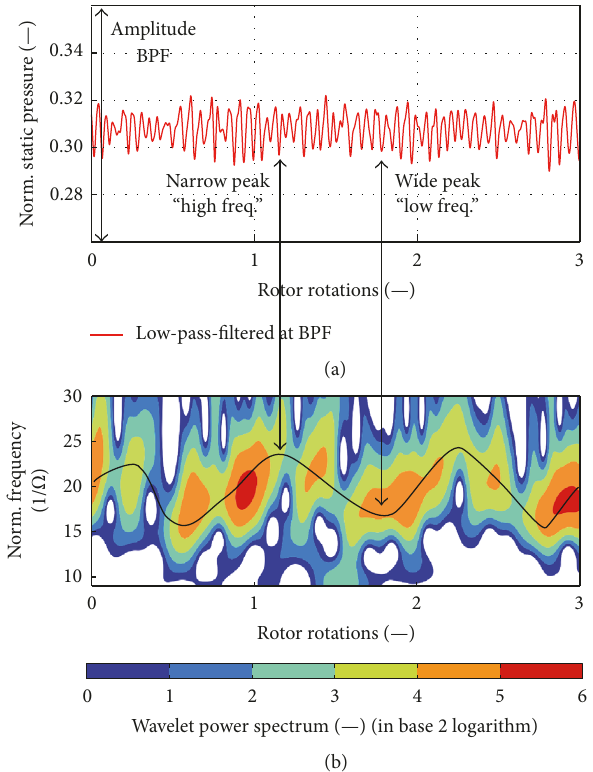
Figure 10: Rotating instability characterization with casing pressure signals over three rotor revolutions (a) and wavelet power spectrum